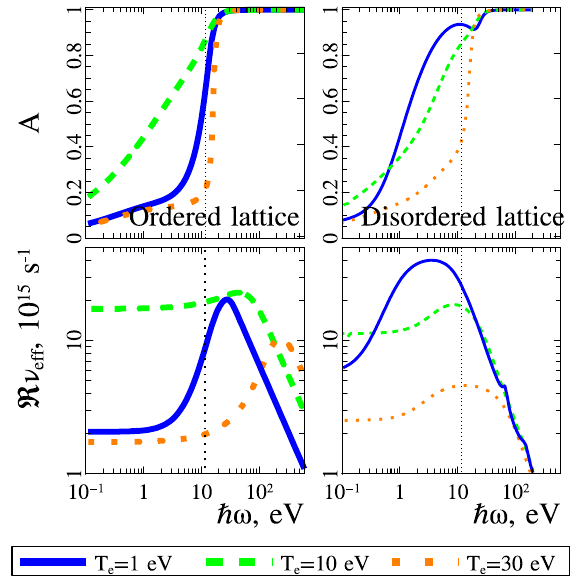
Figure 2. The absorption coefficient and the real part of the complex collision frequency of electrons (46) in a solid-density aluminum plasma are shown as a function of the laser frequency ¯ h ω for ion temperatures T i = 0.04 eV and different electron temperatures T e (see legend). Thick curves (left column) refer to the case of an ordered lattice with electron–phonon interactions and Umklapp processes, and thin curves (right column) refer to a disordered lattice with electron–ion and electron–electron